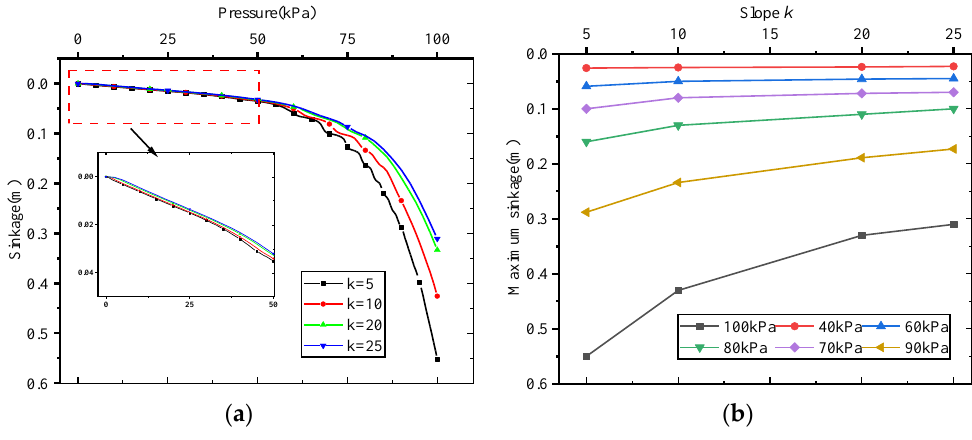
Figure 12. ( a ) Pressure-sinkage curve and ( b ) the maximum displacement variation curve with k .